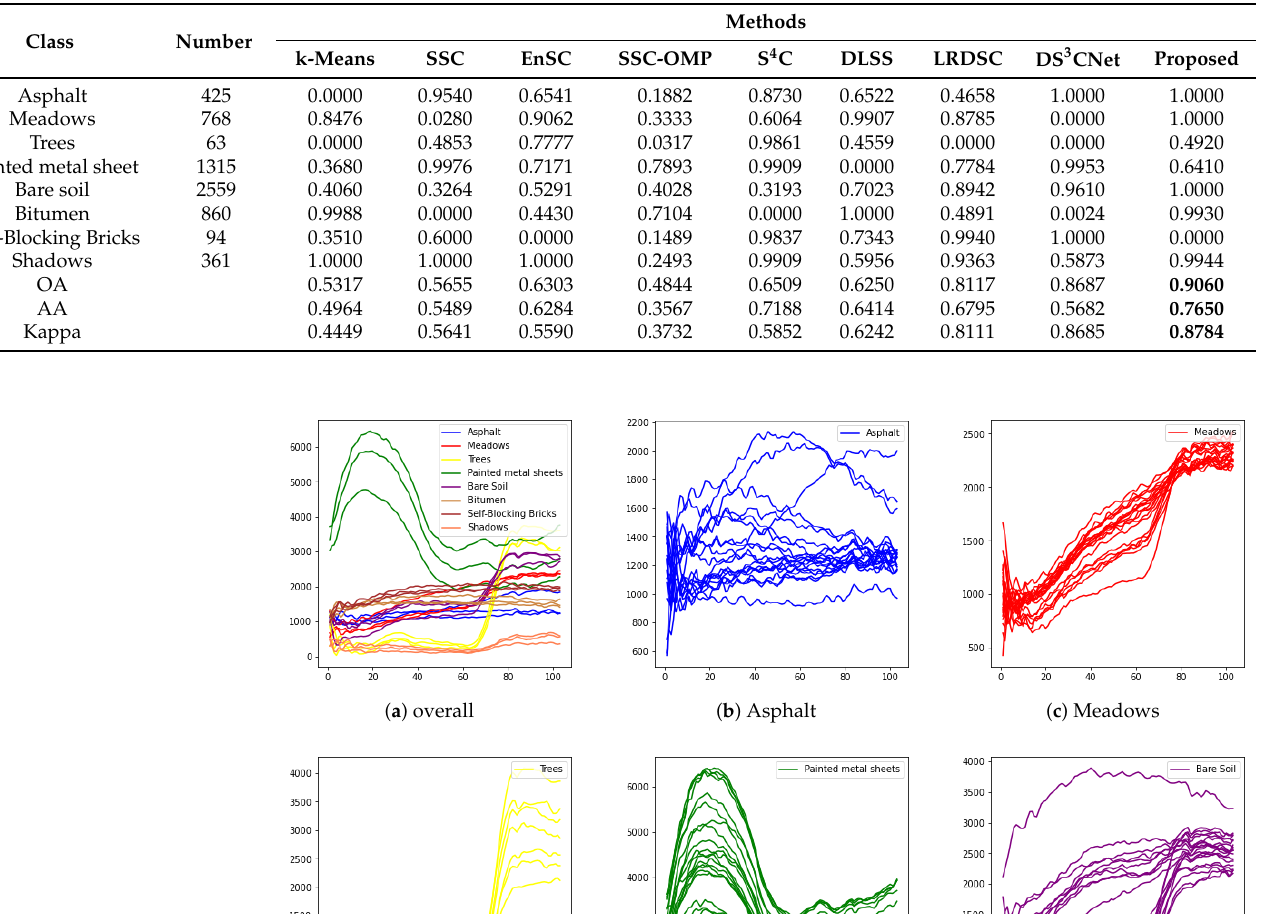
Table 5. The clustering results of the University of Pavia dataset. The best results are highlighted in bold.